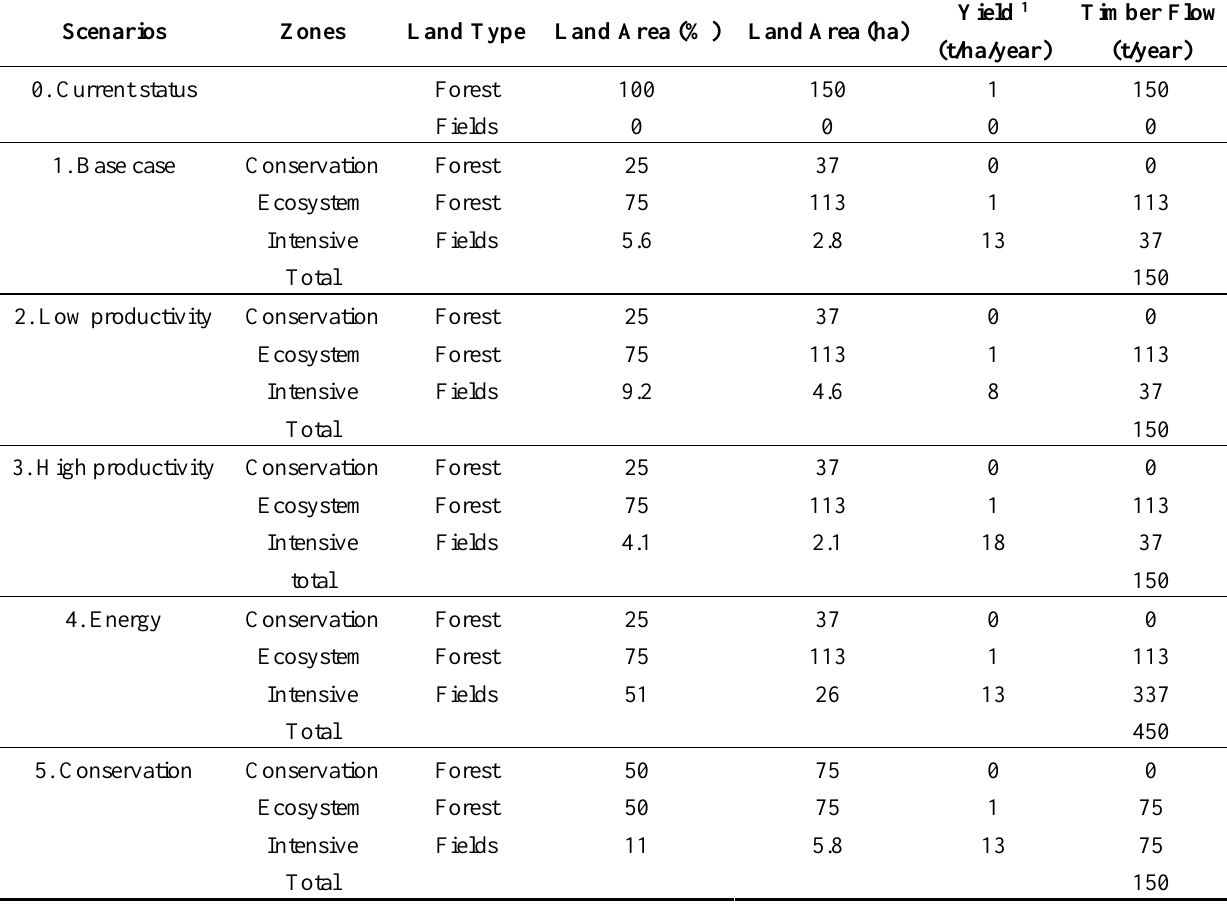
Table 5. Examples of various potential zoning scenarios for the St-Benoît-du-Lac Abbey.